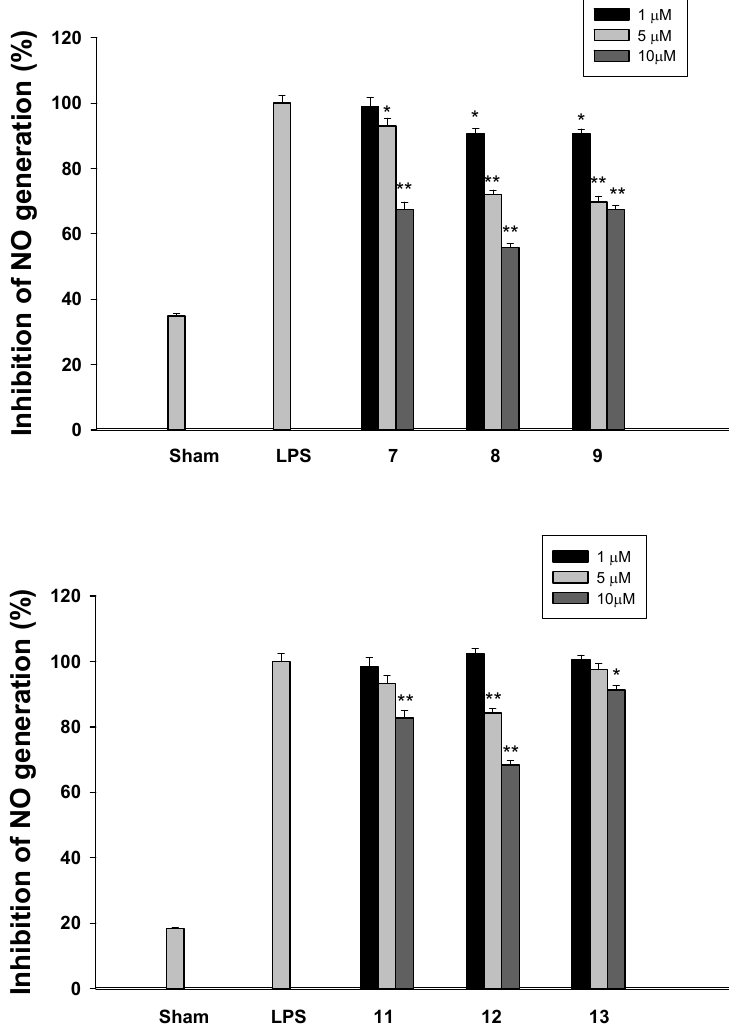
Figure 2. Effect of modafinil derivatives 7–9 and 11–13 on NO generation in LPS- stimulated BV-2 microglia cells. Cells were treated with 100 ng/mL LPS, and then various concentrations of these compounds (1 µM, 5 µM, and 10 µM) were added for 24 h at 37 °C. Values indicate inhibition of NO production from culture supernatants of LPS-treated cells with or without compounds. Data represent the mean ± standard deviation of three observations. * < 0.05, ** < 0.01 indicate significant difference compare with LPS alone